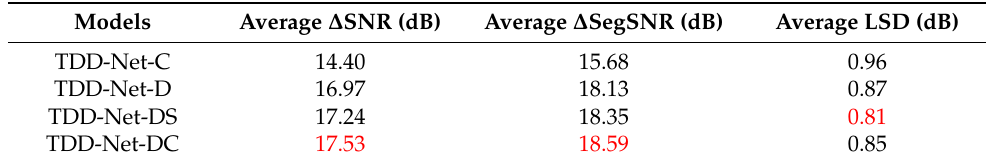
Table 2. Comparison with TDD-Nets using different convolution blocks. The red numbers were the best results of the corresponding